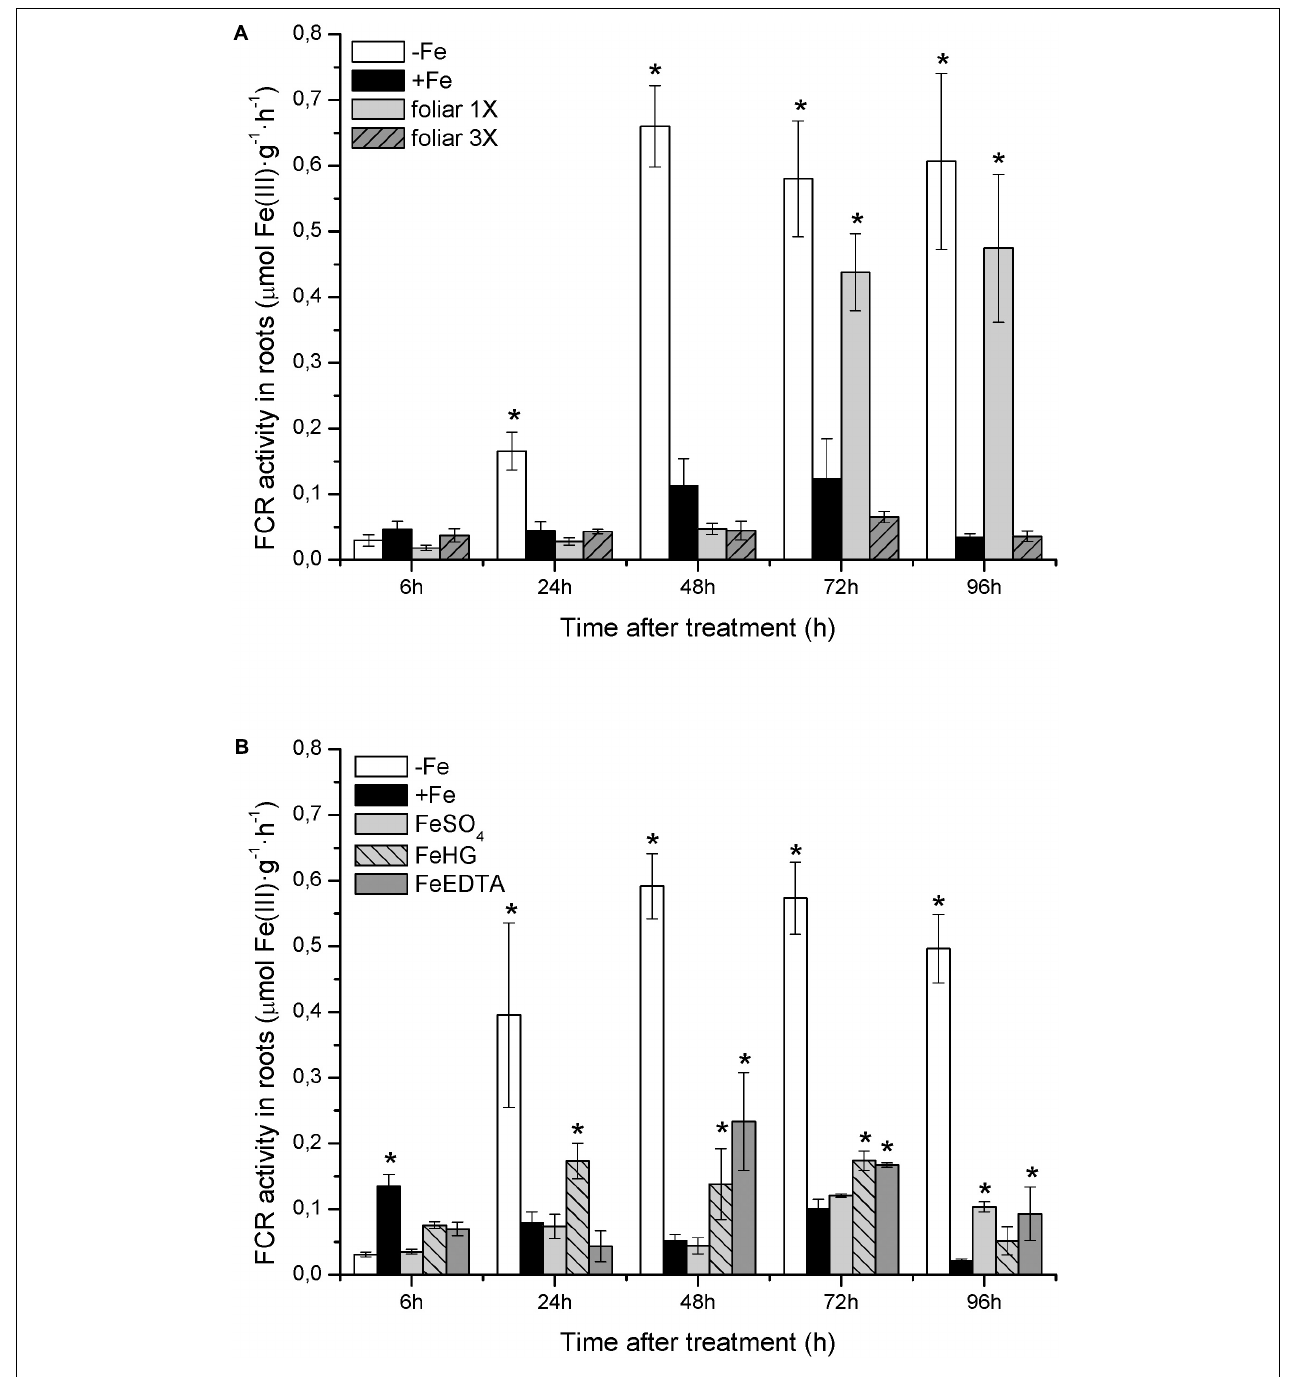
FIGURE 2 | Fe(III)-chelate reductase (FCR) activity in cucumber roots measured from: (A) Experiment I and (B) Experiment II. Data are means ± SE ( n = 5, from five independent roots). Asterisks indicate significant differences between treatments at P < 0.05 based on one-way ANOVA and Fisher’s post hoc